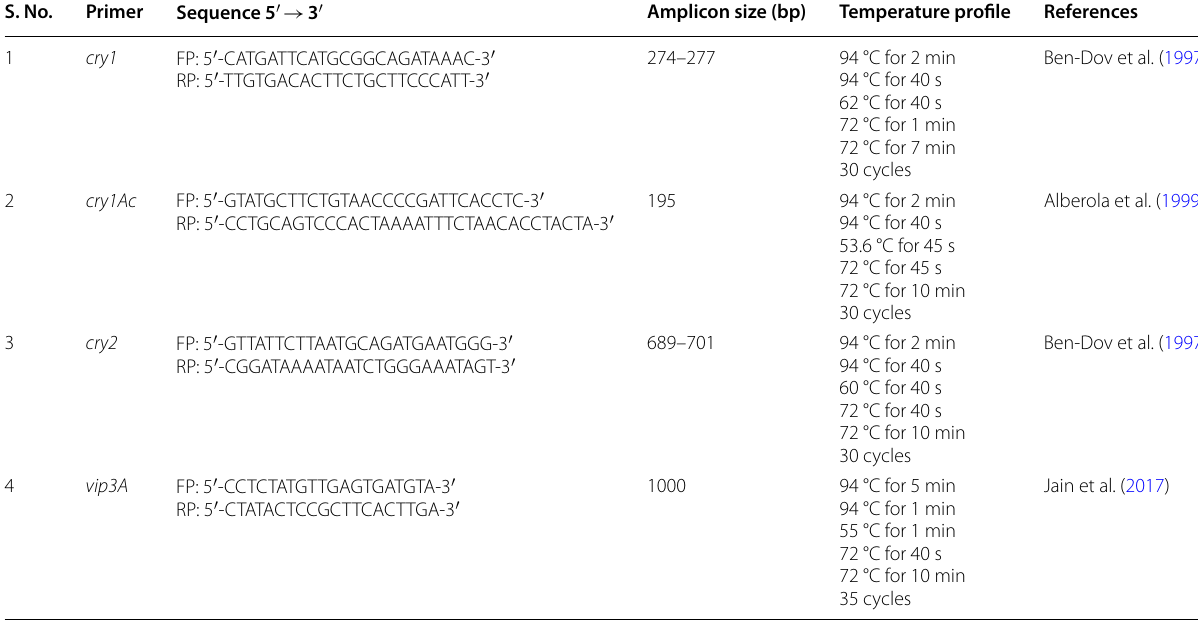
Table 1 Oligonucleotide primers and PCR conditions used for screening of cry and vip3 genes S.